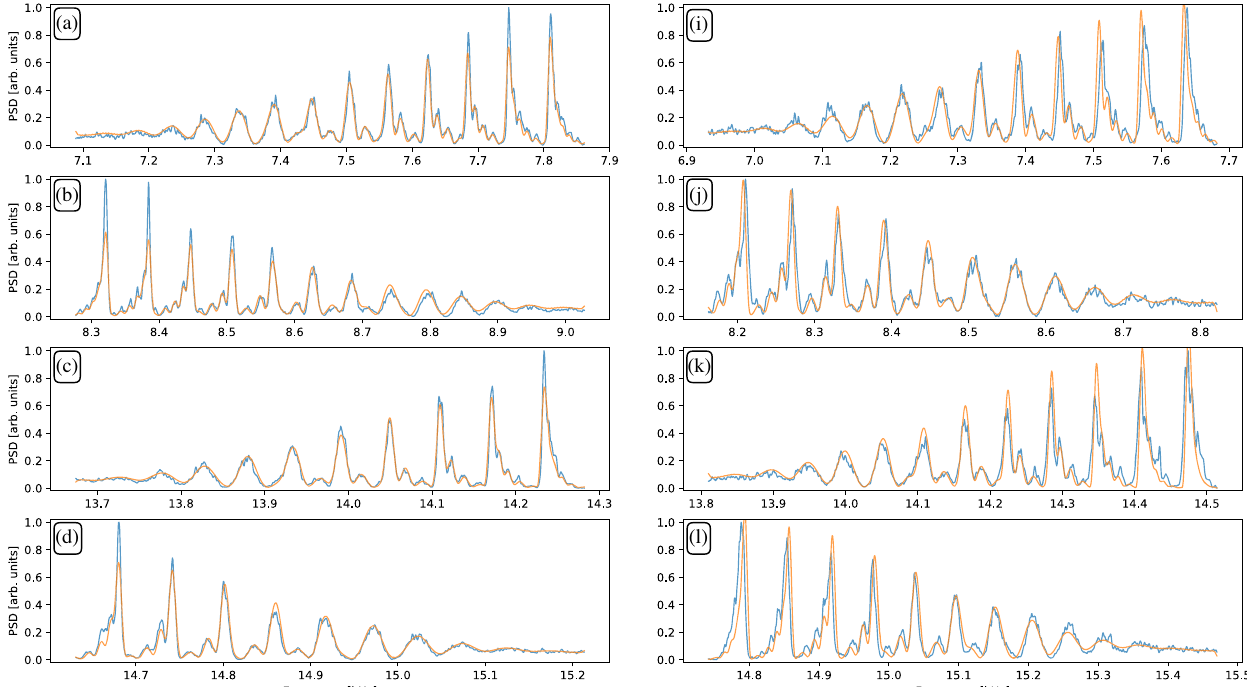
FIG. 5. Measured (blue lines) transverse Schottky spectrum for LHC fill 7443, compared with the best fitted spectrum (orange lines) obtained from the third scenario strategy. A – D and I – L region labels correspond to frequency ranges equivalently located as shown in Fig. 3 for fill